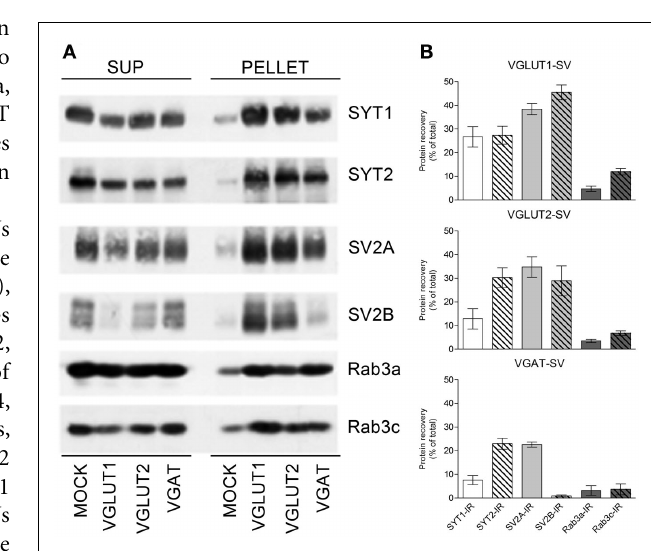
FIGURE 5 | Expression of SYT1, SYT2, SV2A, SV2B, and Rab3a and c in VGLUT1 + ,VGLUT2 + , andVGAT + SVs. (A) Glutamatergic and GABAergic SVs were immunoisolated from the LS1 fraction of rat cerebral cortex using beads coupled with either rabbitVGLUT1,VGLUT2, orVGAT antibodies. After immunoisolation, corresponding amounts of pellet and supernatant (SUP) fractions were subjected to immunoblotting with anti-SYT1 and -SYT2 antibodies, anti-SV2A/SV2B antibodies, or anti-Rab3a/Rab3c antibodies. (B) Quantification of the recovered immunoreactivities was carried out by densitometric scanning and interpolation of the data into a standard curve of rat brain LS1 fraction, and expressed as percent of the total input of LS1 added to the samples.The percentage of SYT1/SYT2, SV2A/SV2B, and Rab3a/Rab3c immunoreactivities (IR) detected in SVs immunoisolated with anti-VGLUT1 (VGLUT1–SV; upper left/right panel), anti-VGLUT2 (VGLUT2–SV; lower left/right panel), or anti-VGAT (VGAT SV; upper right/right panel) beads are shown as means ( ± SEM) of five independent